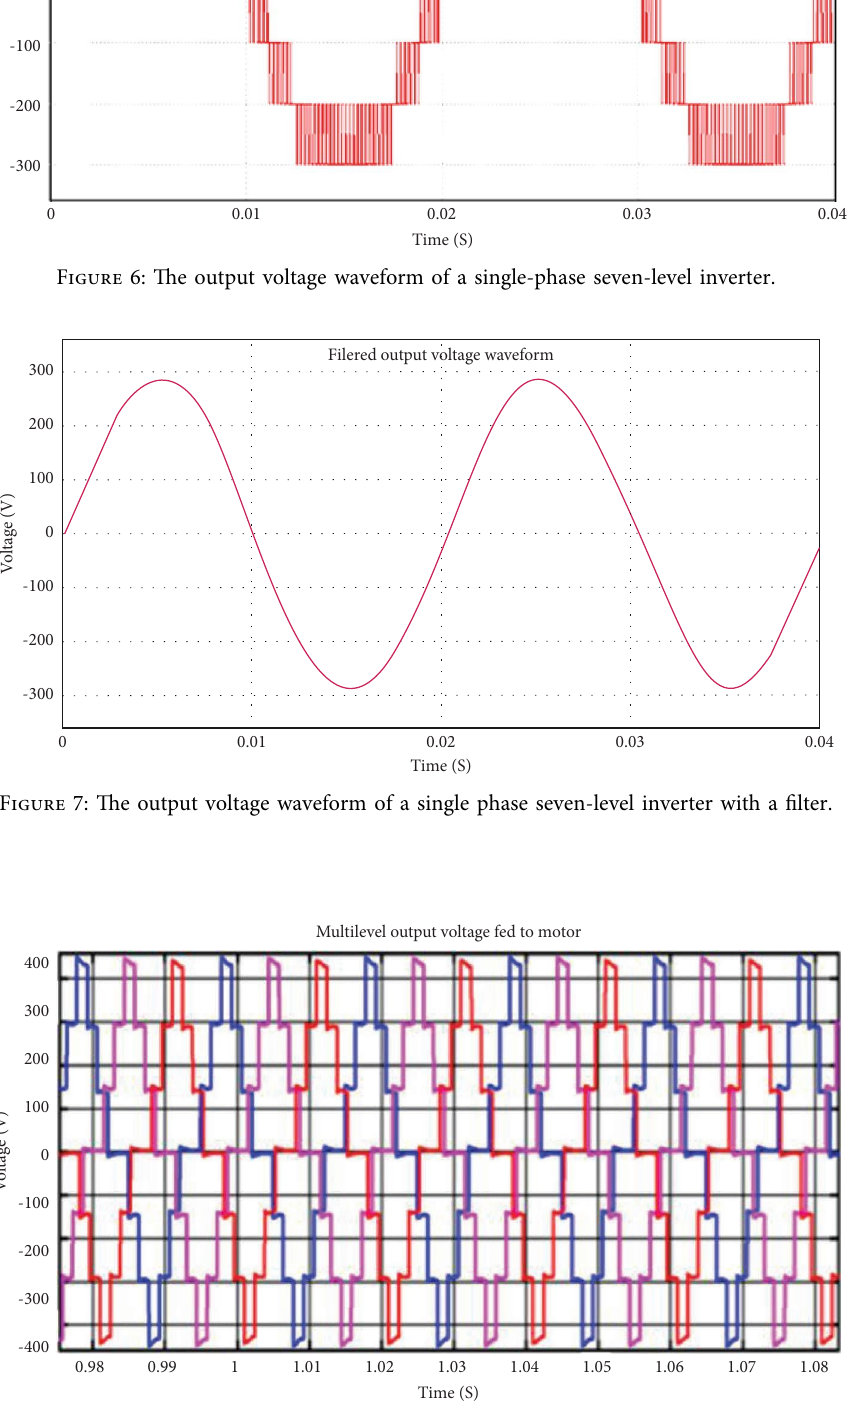
Figure 8: Te output waveform of the seven-level inverter is fed to the motor with a flter.